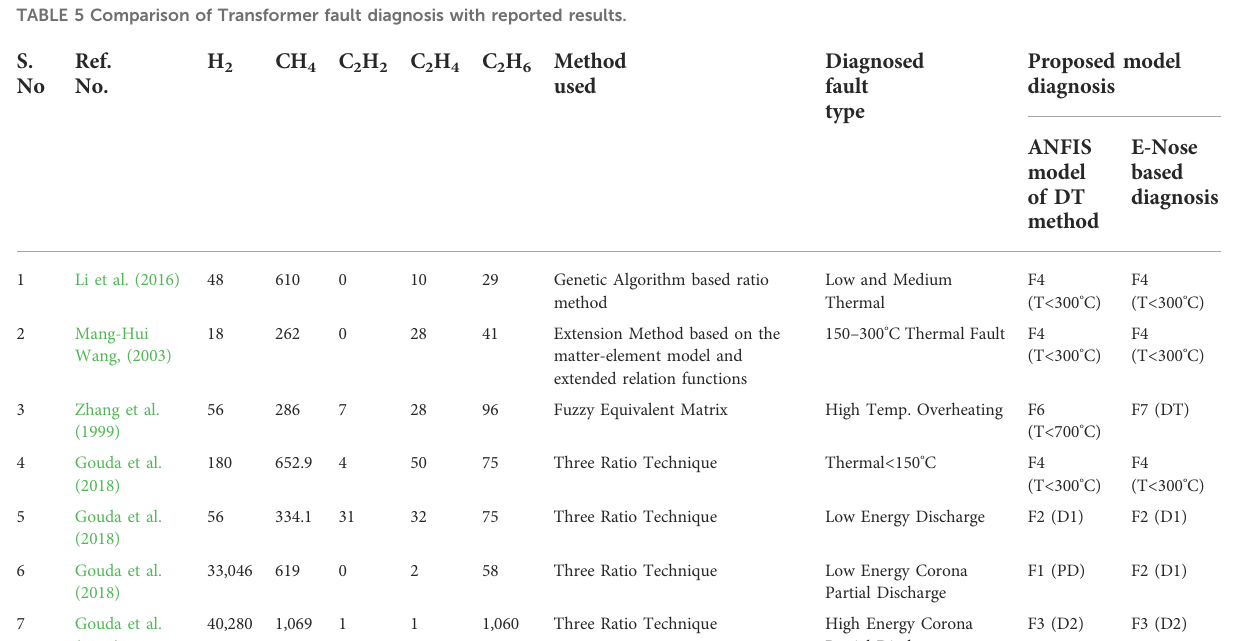
TABLE 5 Comparison of Transformer fault diagnosis with reported results. S. Ref. No No.